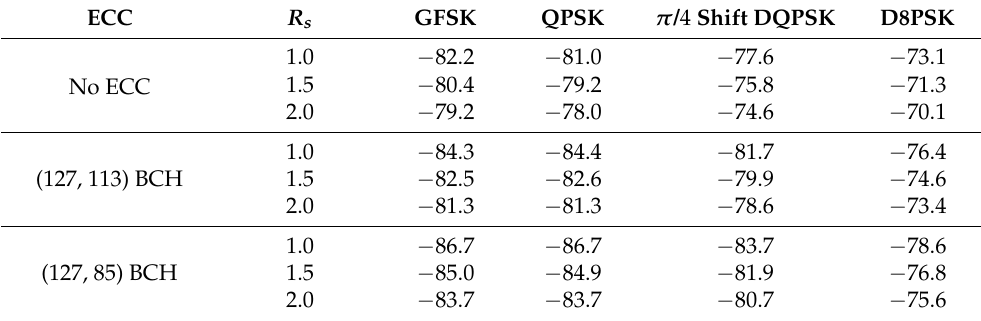
Table 11. Examples of S dBm (dBm). PER ≤ 10 − 3 , L PSDU = 127 bytes, NF dB = 13 dB and I dB = 6 dB.